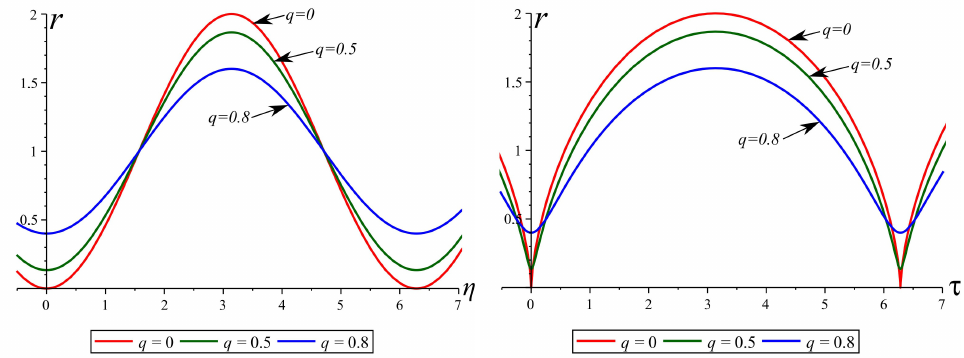
Figure 2. Time dependence of the throat radius for q = 0,0.5,0.8 in terms of η ( left ) and in terms of τ ( right ).